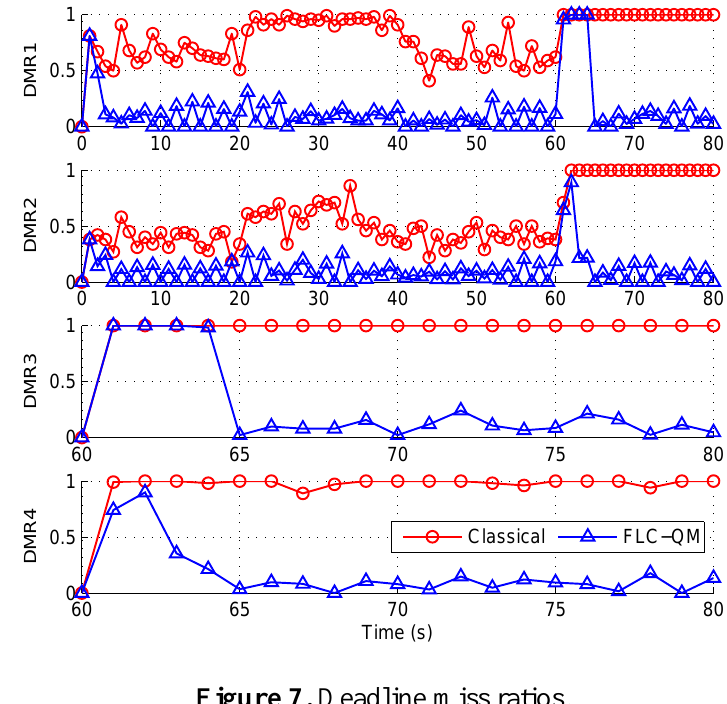
Figure 7. Deadline miss ratios.